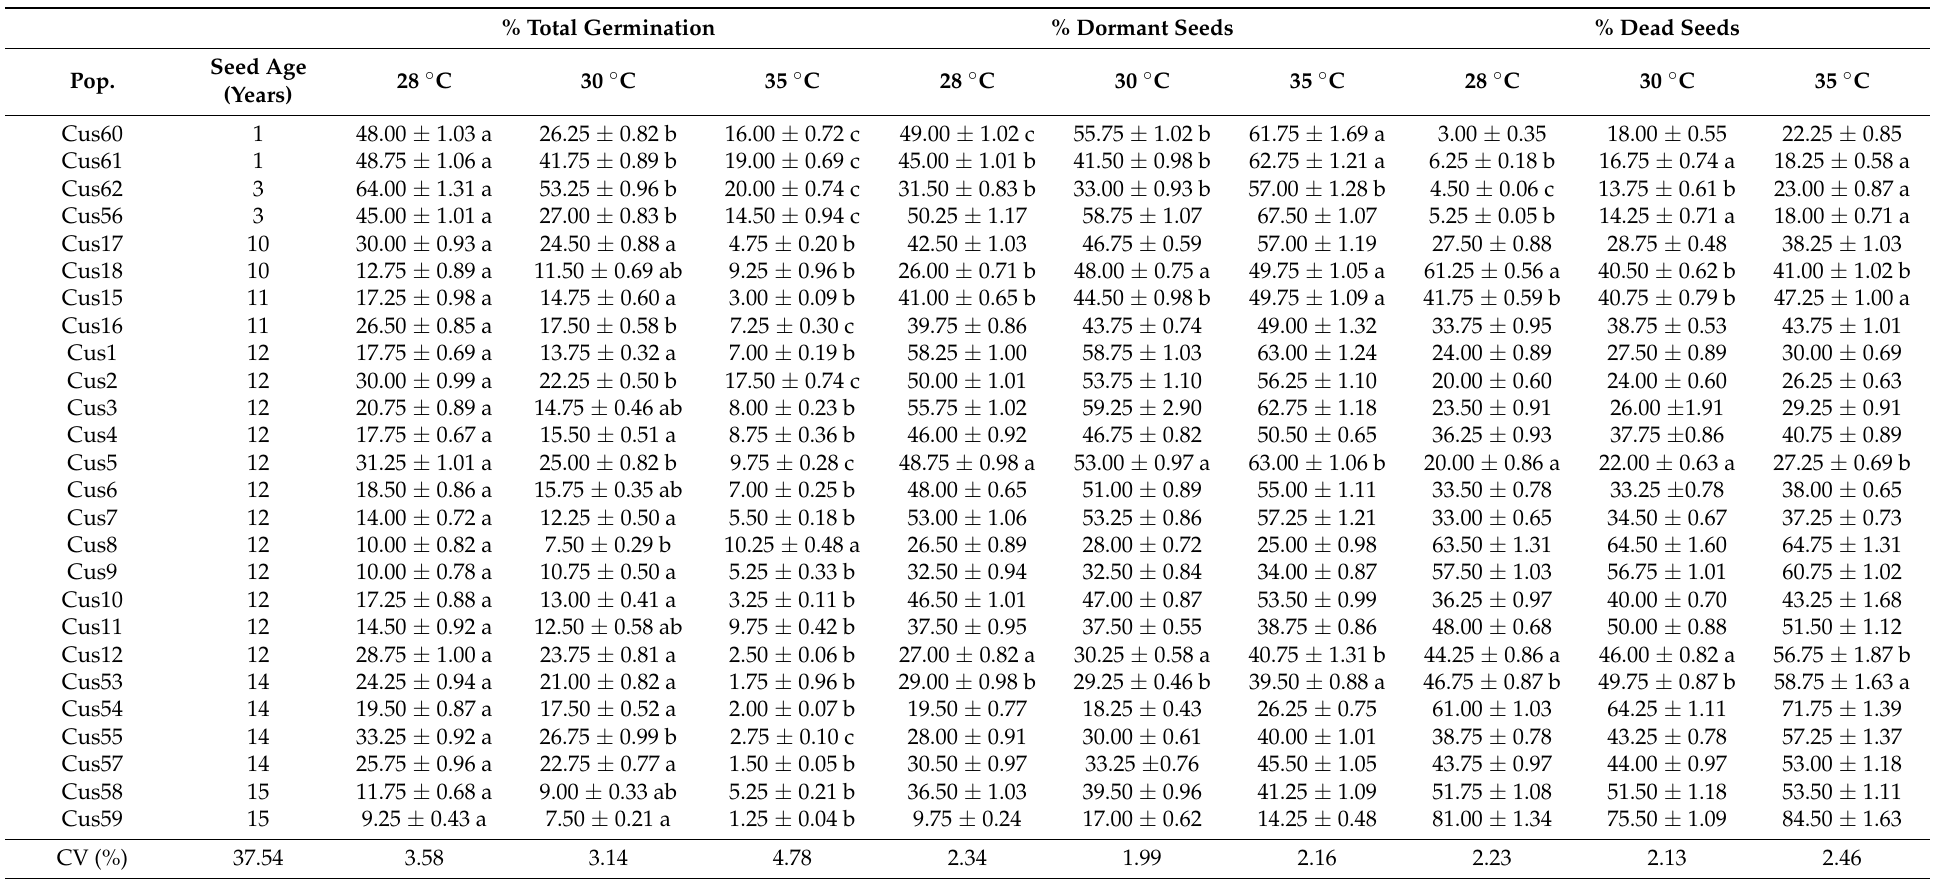
Table 3. Total percentage of germinated, dormant, and dead seeds of 26 test populations of C. campestris at 28, 30, and 35 ◦ C temperatures. % Total Germination % Dormant Seeds % Dead